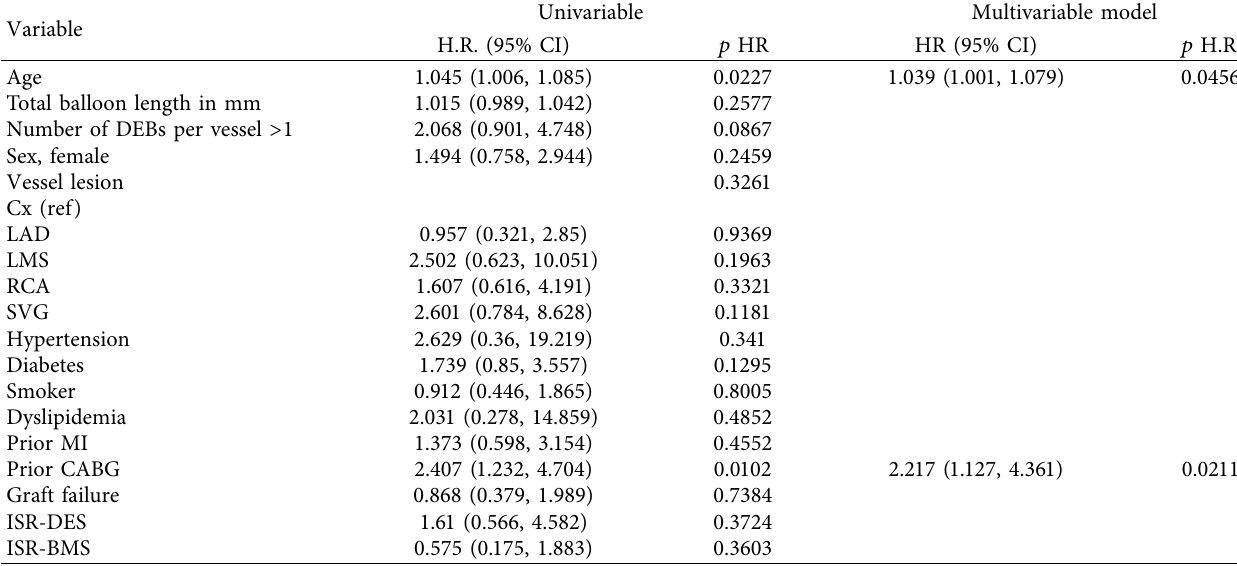
Table 6: Univariable and multivariable Cox proportional hazard (H.R.) for MACE.